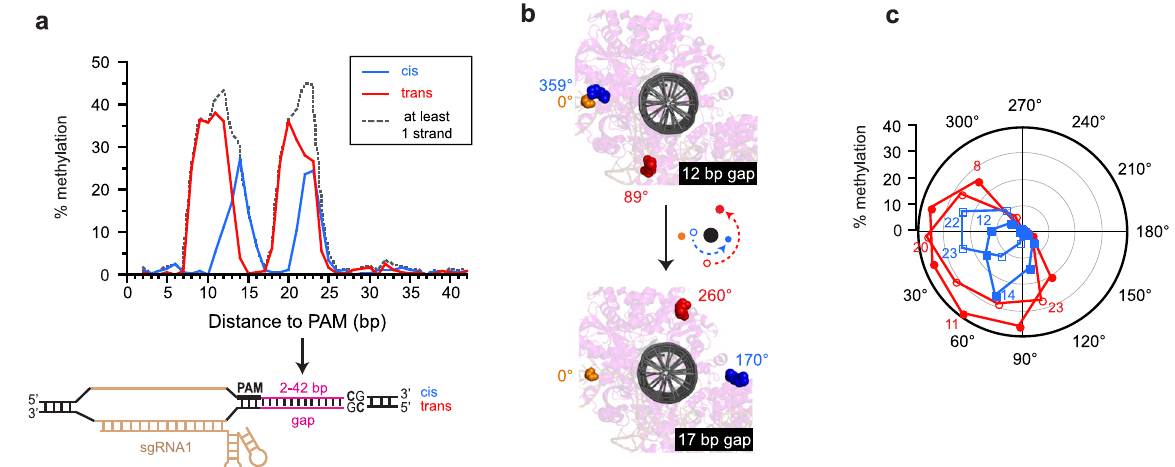
Figure 2. The frequency of methylation at the target CpG site varies periodically with its distance from the PAM site. ( a ) Frequency of methylation for cis and trans strands. The dotted line indicates the fraction of the target sites that are methylated on at least one strand assuming that strand-specific methylation is independent. The cis strand is defined as the strand with the PAM and protospacer. ( b ) Side views of the model at good (12 base pair) and poor (17 base pair) gap lengths for methylation. Orange, C-terminus of dCas9; blue, N-terminus of MC bound to the cis strand; red, N-terminus of MC bound to the trans strand. dCas9 is shown in the background. The MTase is not shown except for its N-terminus of MC. Angles relative to the position of the C-terminus dCas9 are indicated. ( c ) Polar graph indicating the fraction methylated on the cis (blue) and trans (red) strands as a function of the angle as defined in ( b ). The colored numbers indicated the length of select gap lengths and open symbols indicate data points in the second rotation around the DNA helix. The graph shows how efficient methylation only happens with the N-terminus of MC is positioned on the same side of the DNA as the C-terminus of